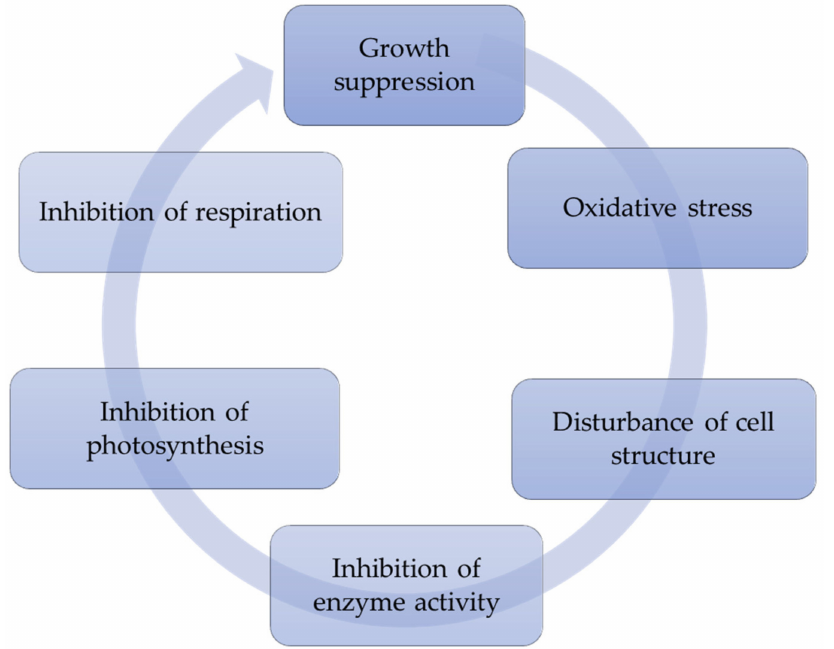
Figure 3. Physiological and biochemical mechanisms of influence of allelopathically active com- pounds of aquatic vascular plants on target phytoplankton